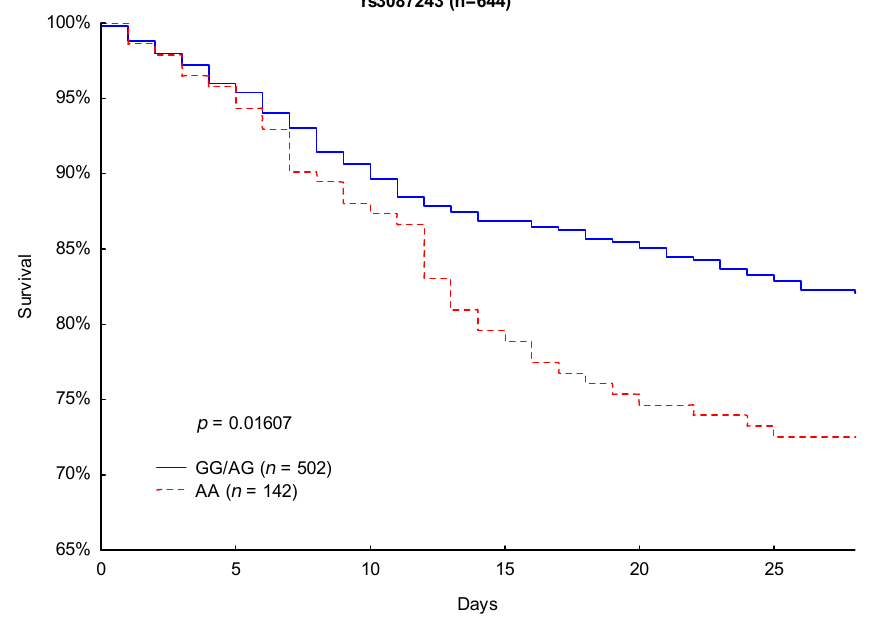
Figure 3. Kaplan–Meier survival analysis (28 days) with regard to the CTLA ‐ 4 rs3087243 genotypes. Likewise, Kaplan–Meier survival analysis revealed significantly lower 90-day mortality (24.4% vs. 32.9%; p = 0.0265; Figure 4) and 28-day mortality (14.7% vs. 22.4%; p = 0.0271; Figure 5) in TAA-negative patients compared to that of patients carrying the H1: TAA